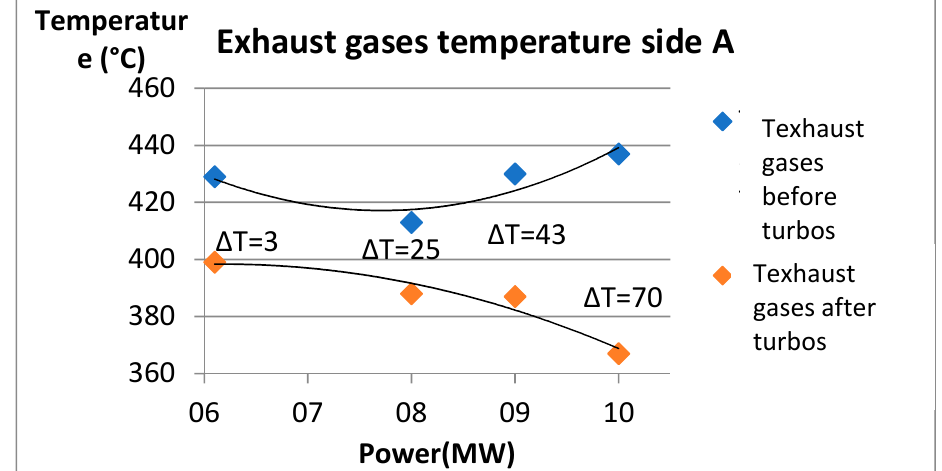
Figure 18. Analysis of the temperature of the exhaust gases on Side A before and after turbos as a function of the power set point.